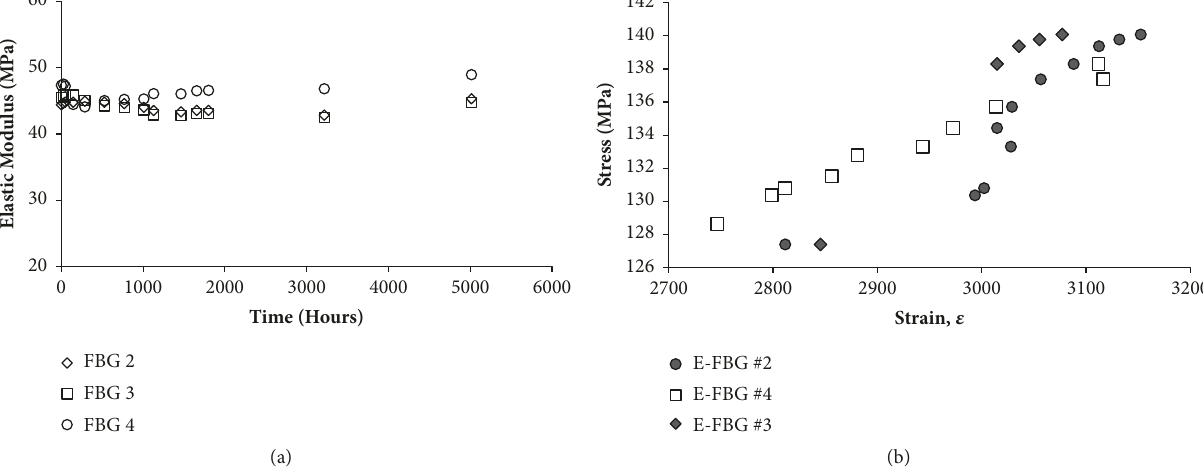
Figure 11: (a) Change in modulus versus time; (b) stress versus strain for FBG